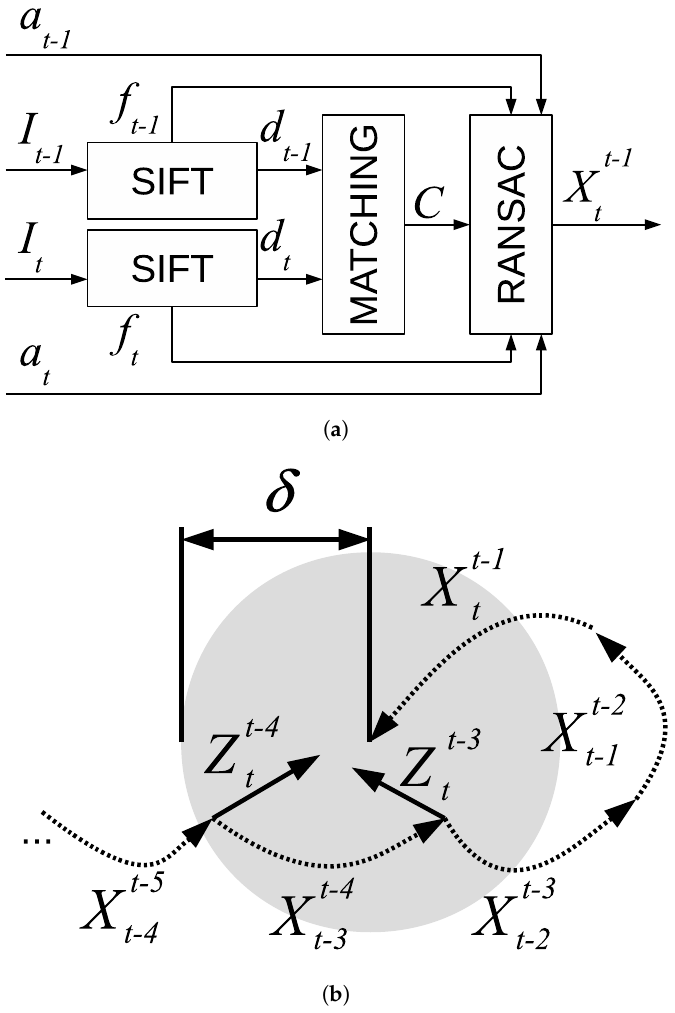
Figure 3. ( a ) Odometry calculation and ( b ) local loop